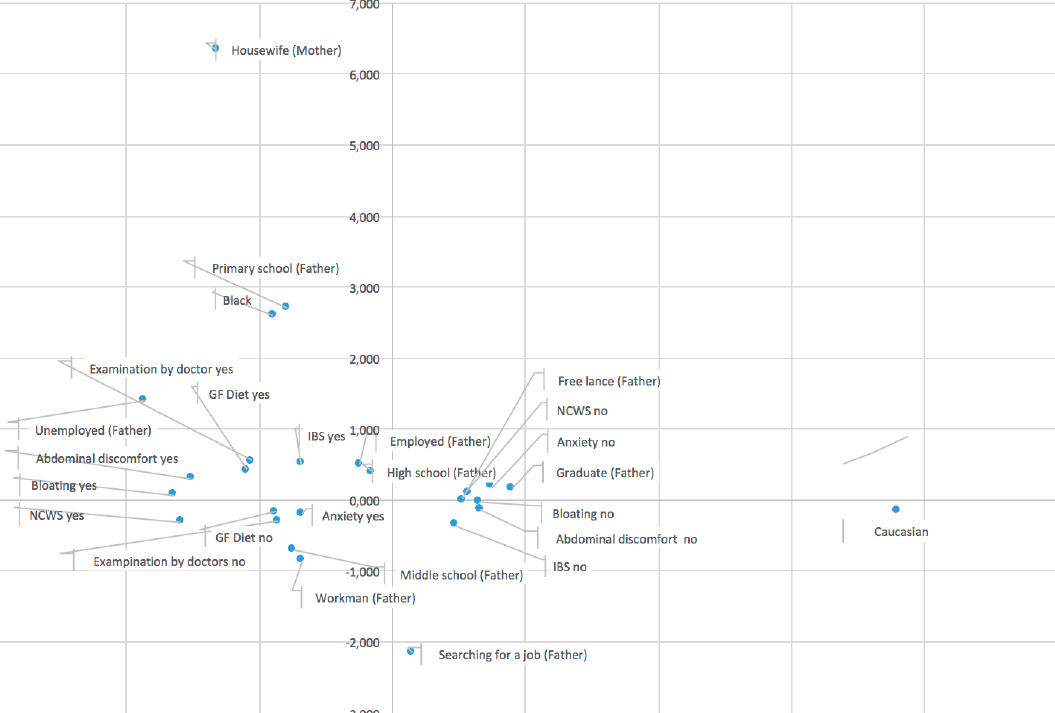
Figure 3. Multiple correspondence analysis shows the relationship between some variables evaluated by the questionnaire including our variable of interest (self-reported NCWS). It identifies some similar groups of individuals following the parental social status (axis 1) and the gravity of symptoms (axis